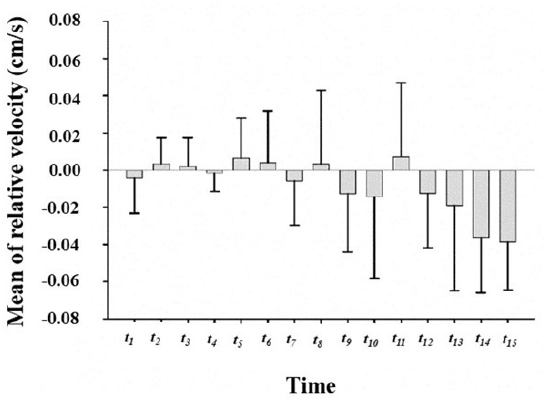
Figure 3 - Histogram of mean relative velocity of rats during exercise fatigue.